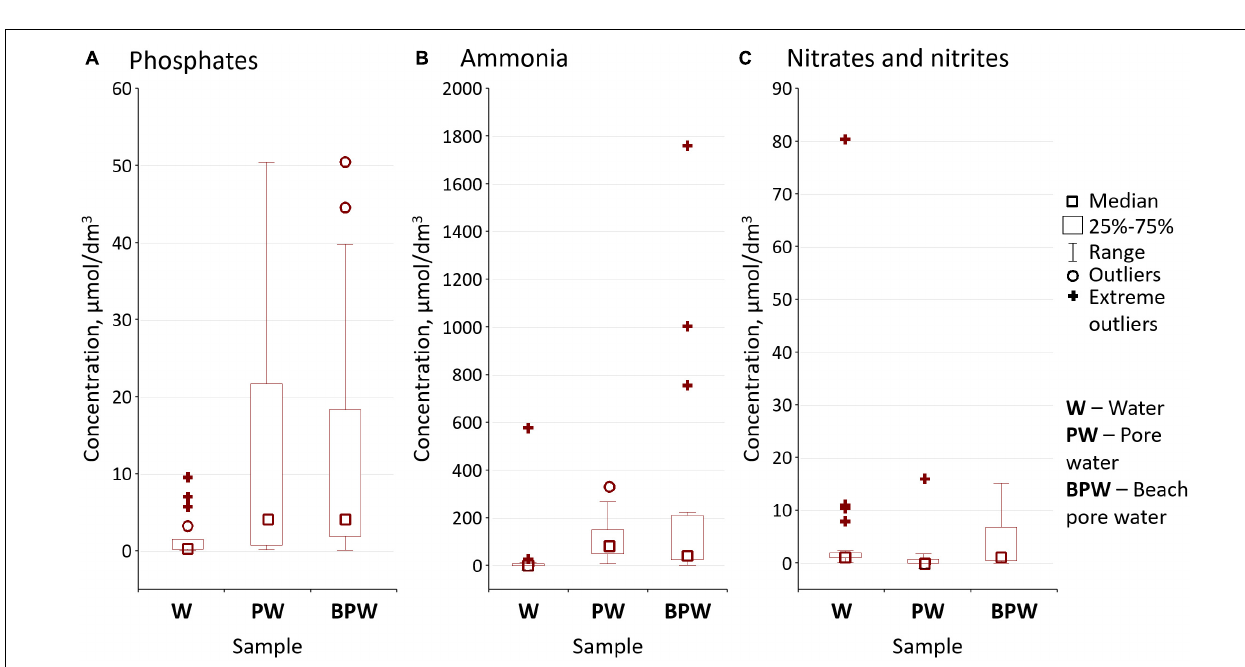
FIGURE 6 | Concentration of (A) phosphates, (B) ammonia, and (C) nitrates + nitrites in water, porewater and beach porewater (sampled from under the detritus) from April (2019) to November (2019) at three sampling sites (P1, R1, R3) in the Bay of Puck (Poland).